Question: Looking at the figure, what chart type is it?
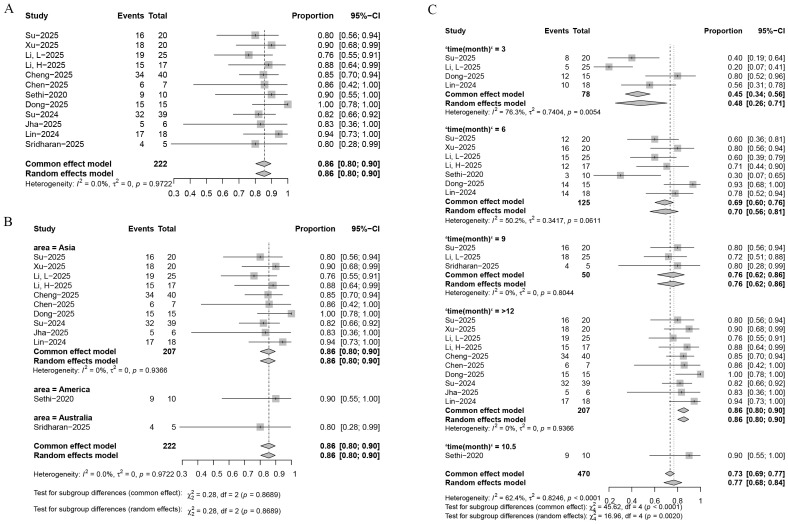
Answer: forest